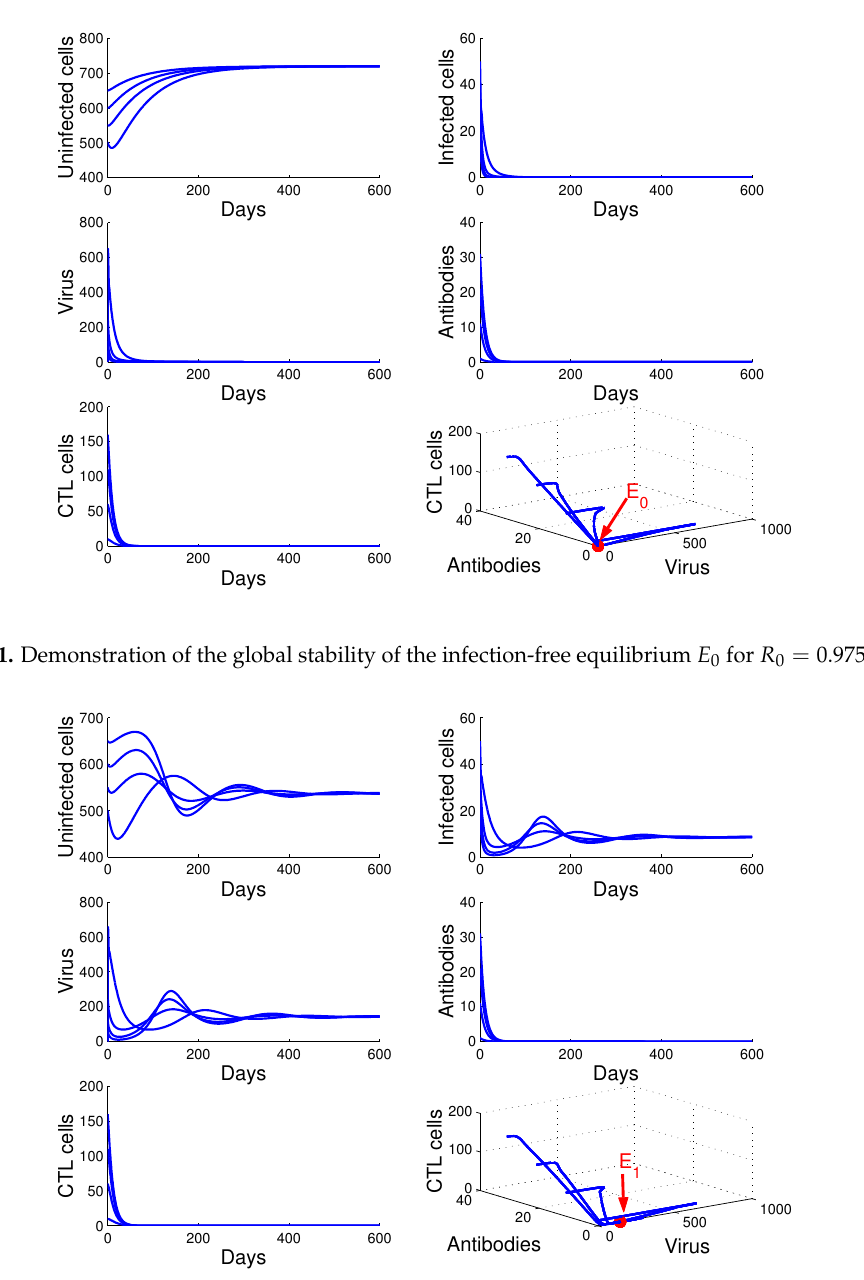
Figure 2. Demonstration of the global stability of the infection equilibrium without immunity E 1 for = 0.0143 ≤ 1, and R Z = 0.1721 ≤ R 0 = 1.3392 > 1, R W 1 1